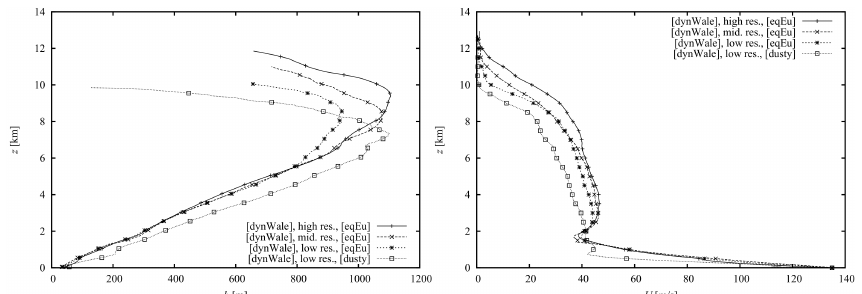
Figure 21. Time-averaged plume radius and velocity. The effect of the resolution and of the decoupling model is shown. In particular, the legend refers to the following simulations: high res. is δ = 2 b 0 / 32; mid res. is δ = 2 b 0 / 16; low res. is δ = 2 b 0 / 8; [eqEu] refers to the equilibrium–Eulerian model; [dusty] refers to the dusty-gas model. All simulations have been performed using the same LES